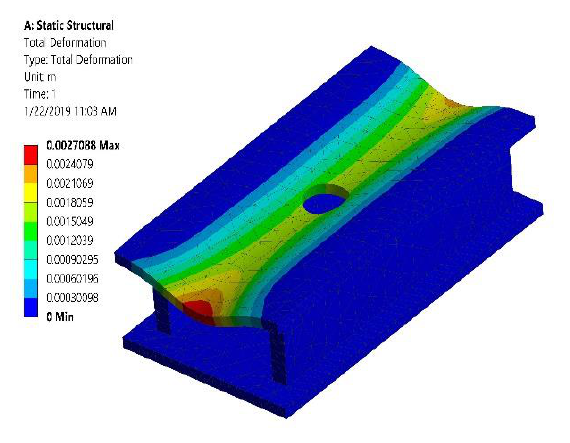
Figure 9. Deformation of